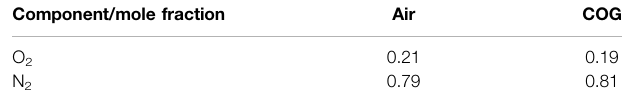
TABLE 7 | Air and COG compositions in the Bio-SOFC plant. Component/mole